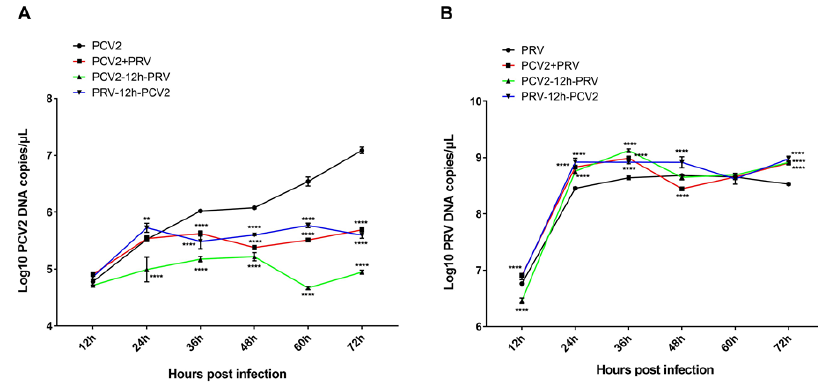
Figure 1. Growth curves of PCV2 ( A ) and PRV ( B ) in different infection groups. PK-15 cells were infected with different combinations of PCV2 and/or PRV for 12, 24, 36, 48, 60, and 72 h, followed by evaluation using real-time PCR. **, p -value < 0.01; ****, p -value < 0.0001.